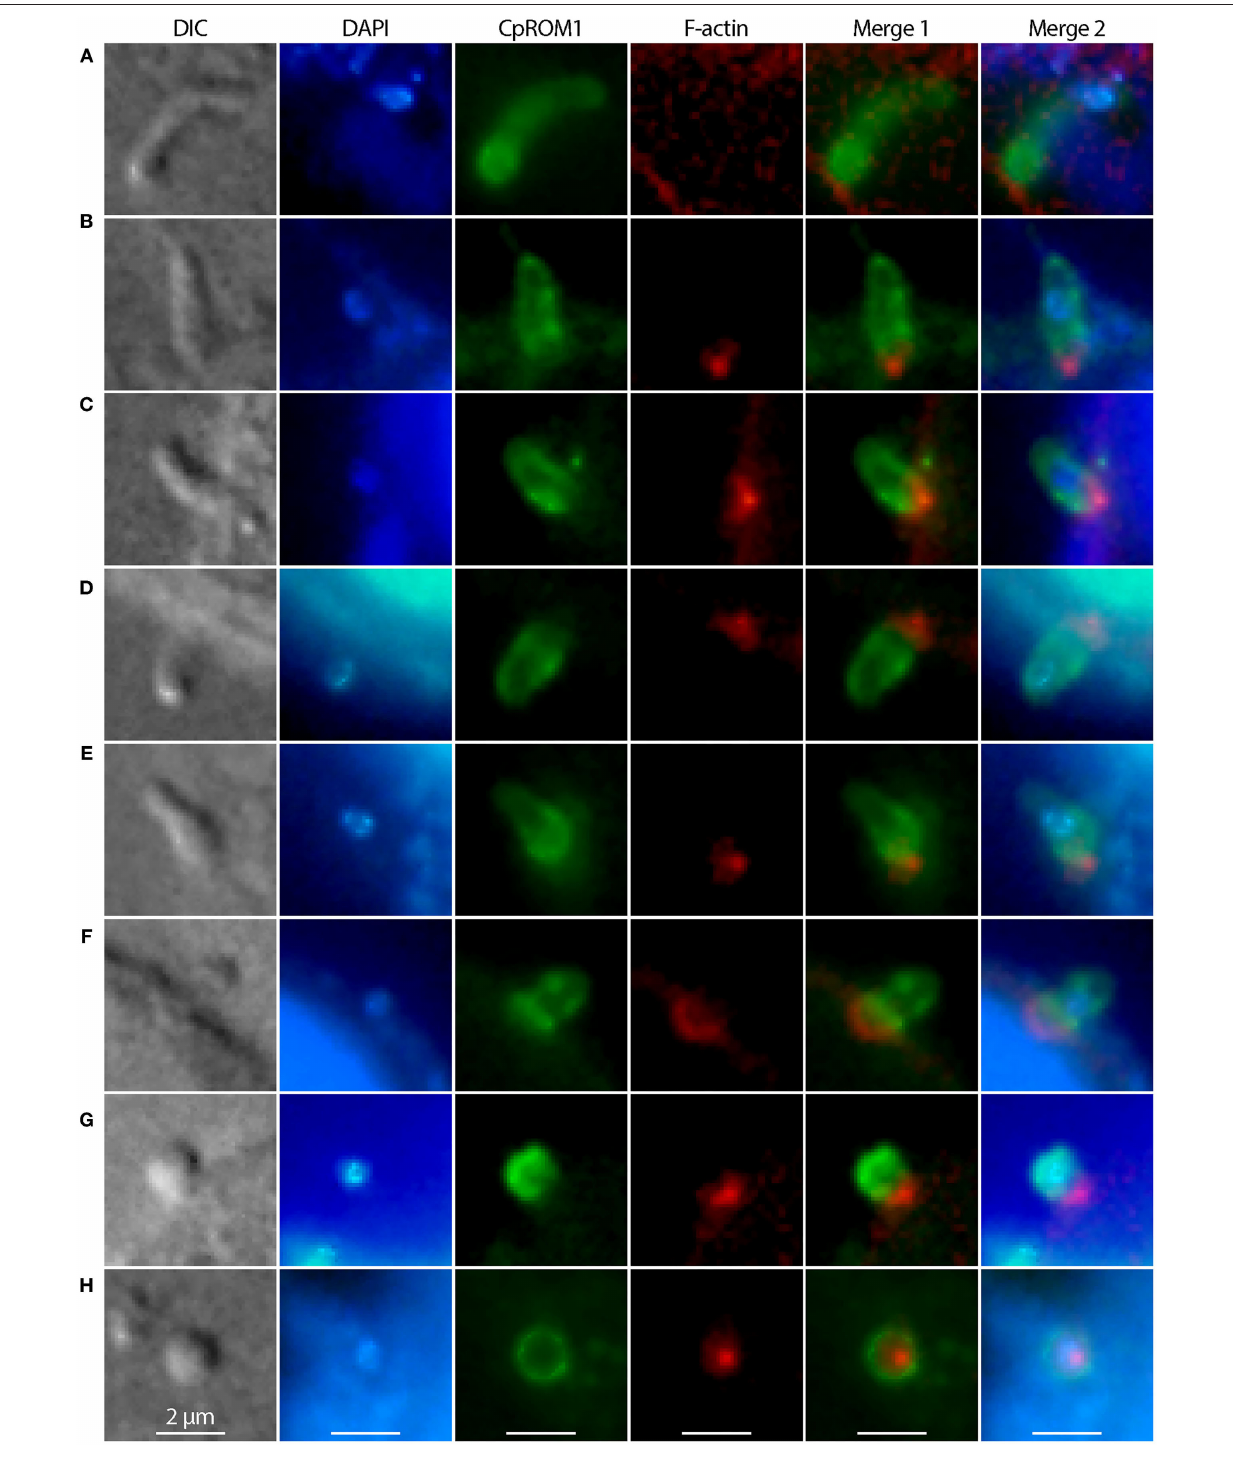
Frontiers in Veterinary Science |